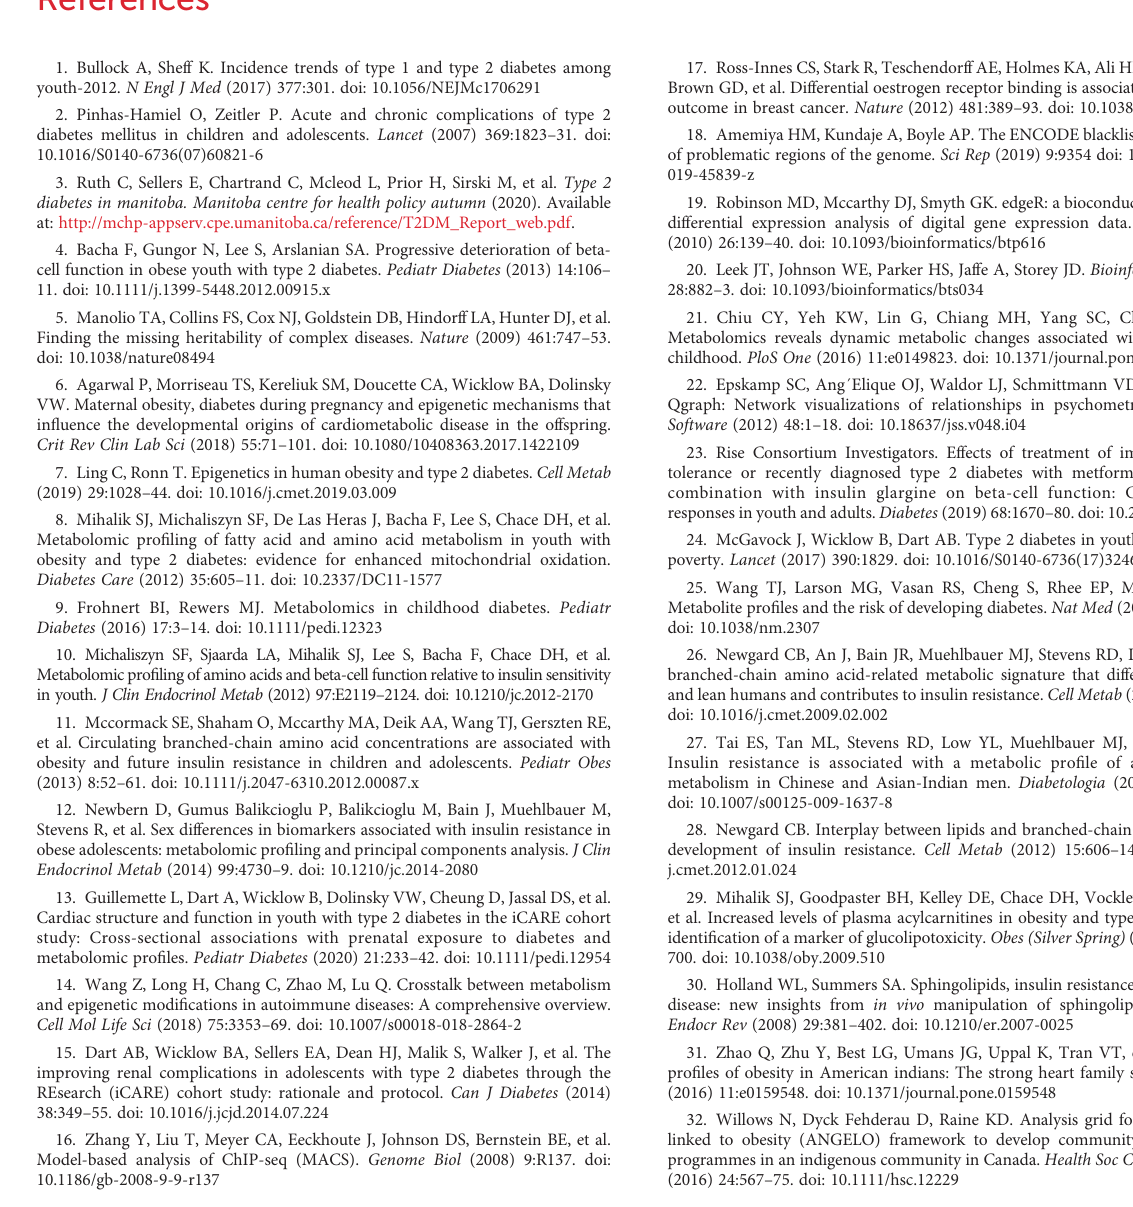
SUPPLEMENTARY FIGURE 6 Visualization of DMRs genomic location using IGV genome viewer. Red color is for the 10 control samples and blue color for 21 T2D samples. All the shown regions have decreased methylation as compared to controls. The two vertical lines in each fi gure shows the approx. peak region. (A) showsgenomic location of DMR nearest toTSSof the gene FFAR1. (B) shows genomic location of the DMR nearest to TSS of gene C1QTNF9. (C) shows genomic location of the DMR nearest to TSS of the gene USF2. SUPPLEMENTARY TABLE 1 Signi fi cant DMRs/peaks fi le. The table contains all the signi fi cant DMRs/ peaks obtained in the DNA methylation analysis. The fi le contains the genomic location of each peak followed by the signi fi cance level.